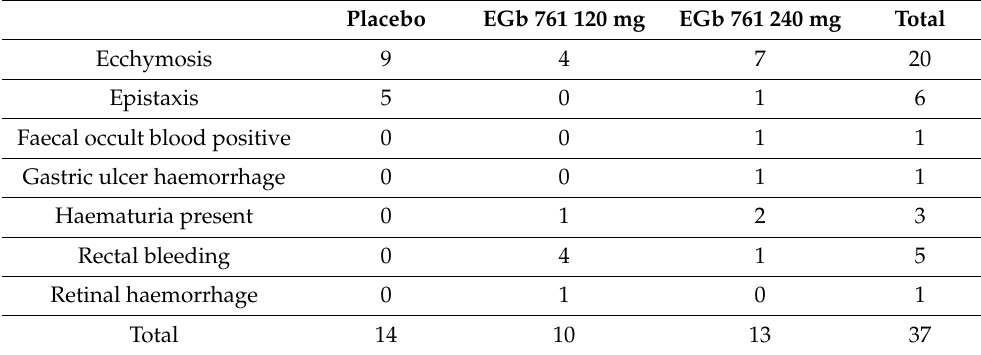
Table 5. Bleeding events documented as adverse events by